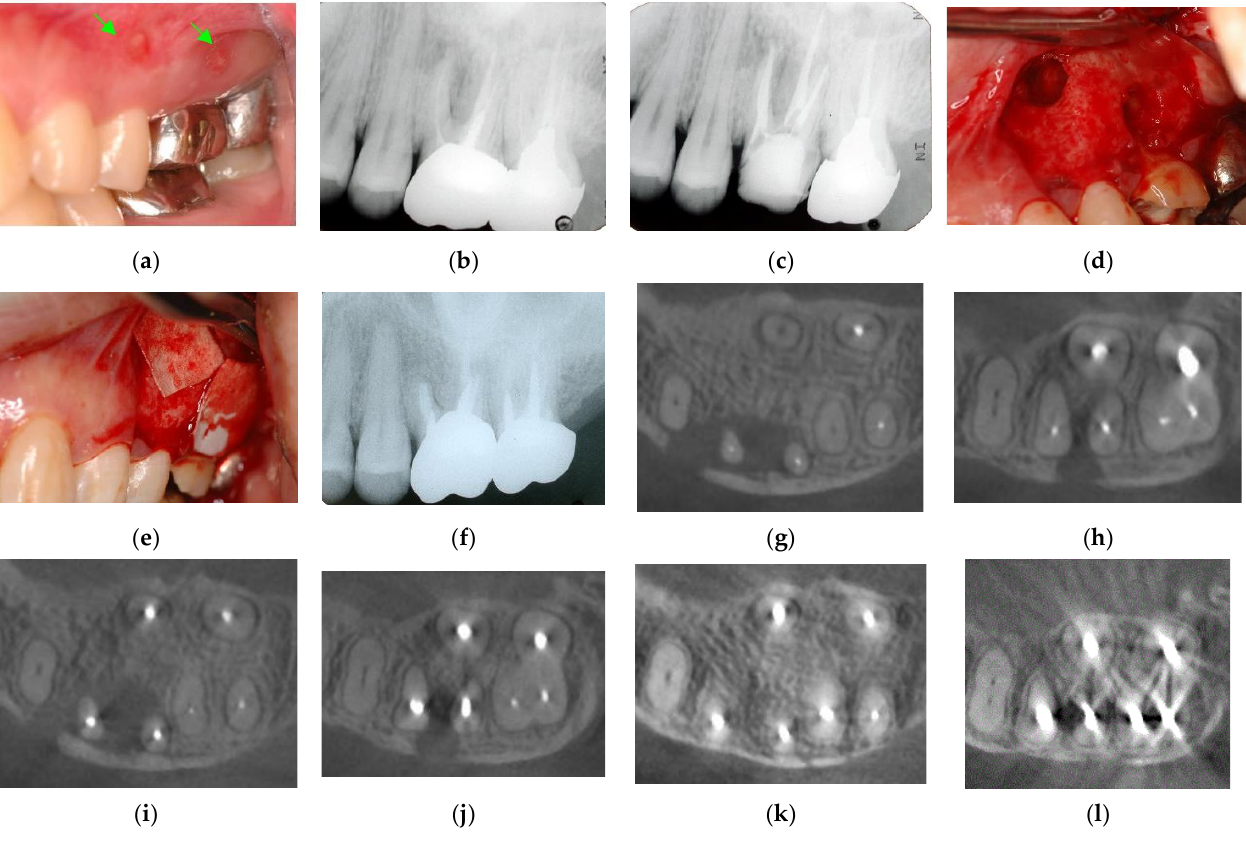
Figure 6. Clinical case 5. Female, age 36 yrs. ( a ) Intraoral view of the upper left first maxilla at baseline, showing two sinus tracts (arrows). ( b ) Preoperative periapical radiograph, in which the “bone” defect appeared as a radiolucent area around the MB root. ( c ) Periapical radiograph after root canal retreatment. ( d ) View after flap retraction and debriding of the defect, showing two bone defects. ( e ) GTR treatment with two resorbable membranes. ( f ) Periapical radiograph after regenerative treatment. ( g , h ) Preoperative CBCT showing a radiolucent lesion on the periapical and bifurcation areas. ( i , j ) CBCT findings after endodontic retreatment. ( k , l ) Follow-up CBCT 10 years after treatment, showing healing of the two bone